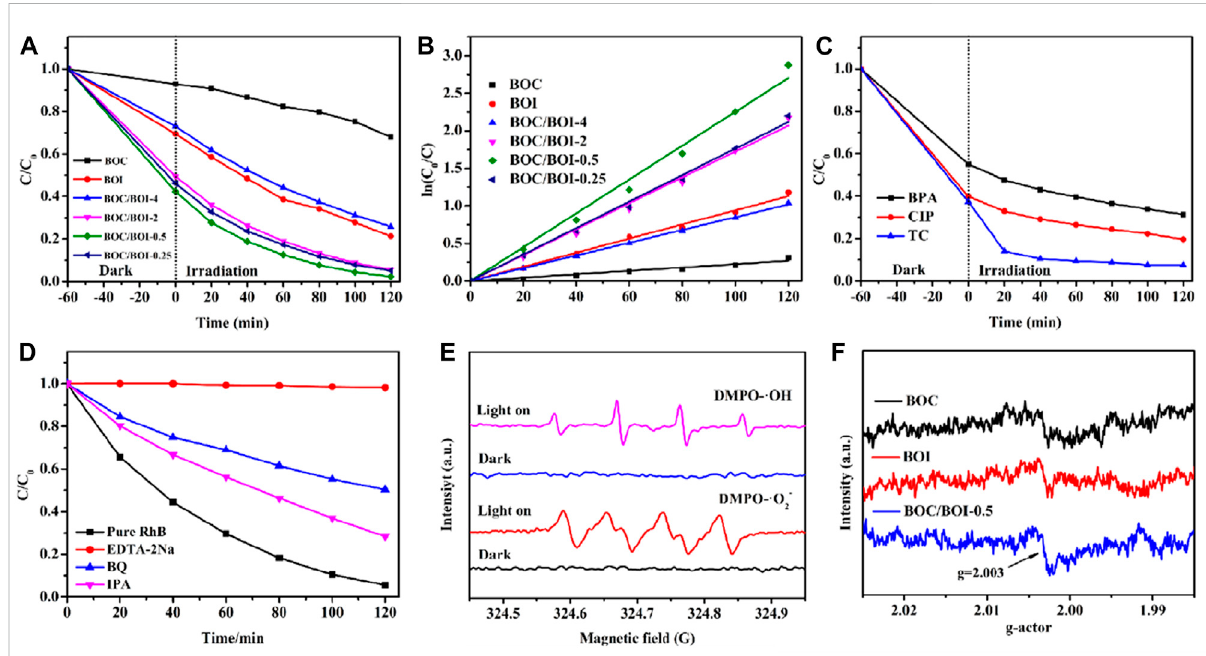
FIGURE 5 (A) Dark adsorption ef fi ciency and photocatalytic degradation of RhB; (B) the pseudo- fi rst-order kinetics of each sample; (C) dark adsorption andphotocatalyticdegradationef fi ciencyofotherpollutants, (D) experimentalresultsofactivegroupcapture, (E) EPRwith · OHand · O 2 − astheactive group and (F) EPR oxygen hole